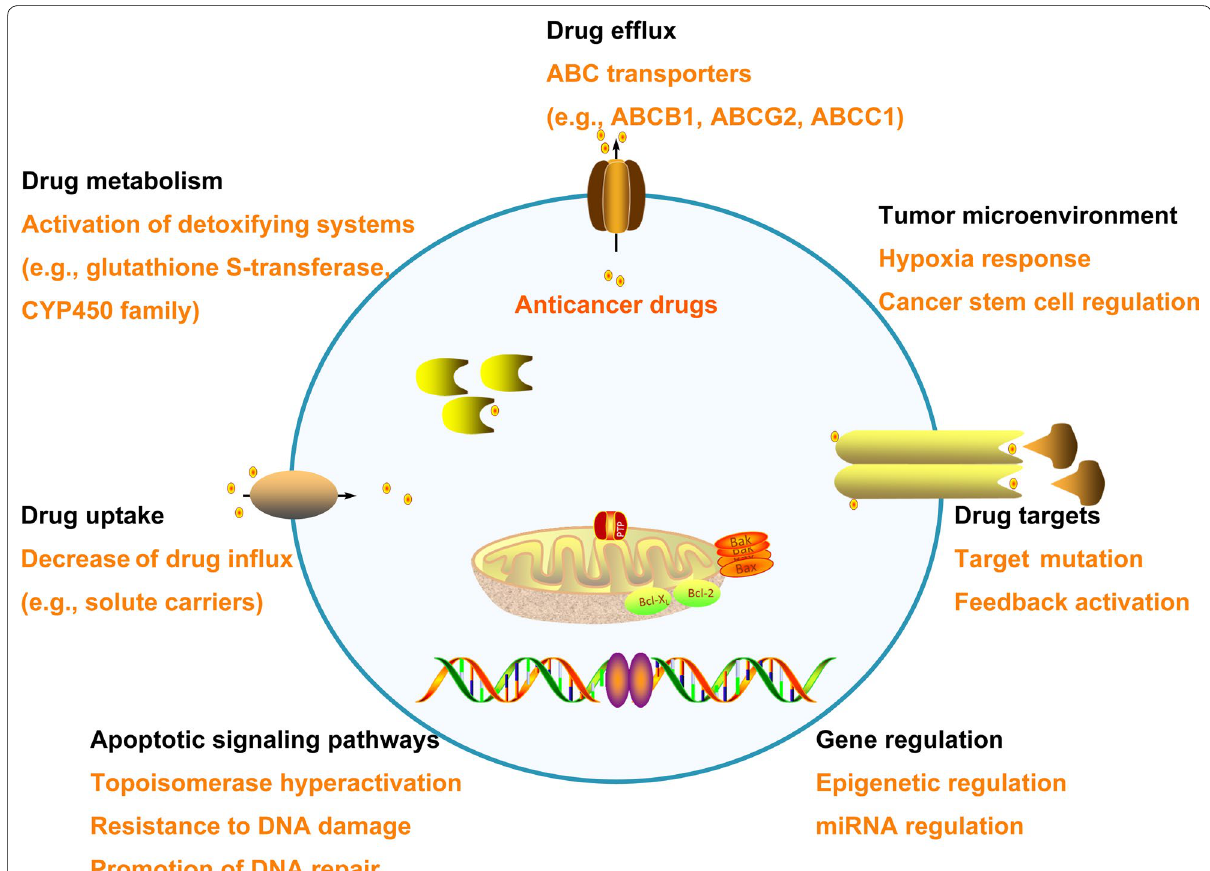
Fig. 1 Complicated mechanisms of multidrug resistance (MDR) in tumor. The main mechanism of MDR is overexpressing ATP‑binding cassette (ABC) transporters to increase drug efflux, resulting in a decrease in intracellular drug concentration. Other mechanisms of MDR are reducing drug uptake by influx transporters, boosting drug metabolism, blocking apoptotic signaling pathways, elevating adaptability by epigenetic regulation and microRNA regulation, mutation in drug targets or feedback activation of other targets and signaling pathways, and change of tumor microen‑ vironment. ABCB1, ATP‑binding cassette subfamily B member 1; ABCG2, ATP‑binding cassette subfamily G member 2; ABCC1, ATP‑binding cassette subfamily C member 1; CYP450, cytochrome